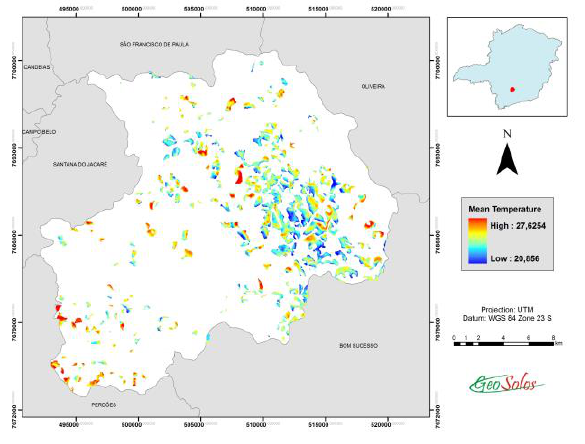
Figure 4. Mean temperature ( o C) of coffee fields of Santo